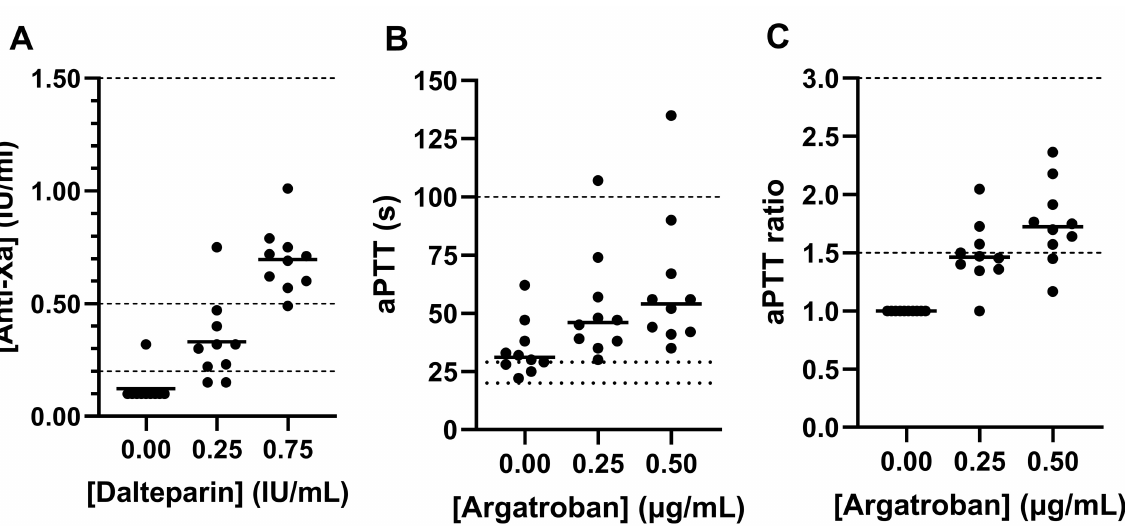
Fig. 2. Coagulation assays in critically ill sepsis patients with new-onset thrombocytopenia ( n ¼ 10) consisting of: (A) Anti-factor Xa (Anti-Xa) in samples without anticoagulant (0.00) and in 0.25IU/mL and 0.75IU/mL dalteparin samples. (B) Activated partial thromboplastin time (aPTT) and (C) aPTTratios in samples without anticoagulant (0.0) and in 0.25 µg/mL and 0.50 µg/mL argatroban samples. Solid lines are group medians, dotted lines are reference intervals for healthy Danish adults, and dashed lines are plasma concentration ranges following the guidelines when treating patients with dalteparin and